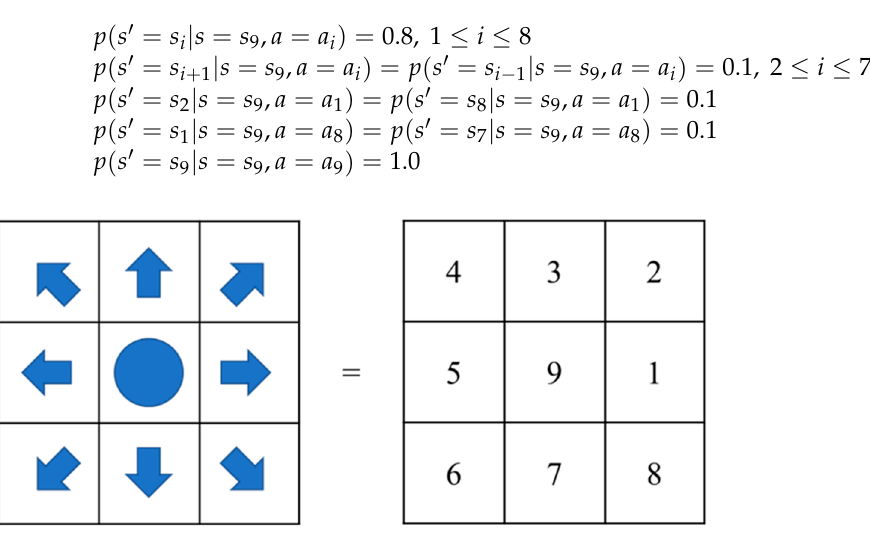
Figure 2. Behavior number: 1 to 8 correspond to the adjacent 8 directions; 9 represents the position of the agent.